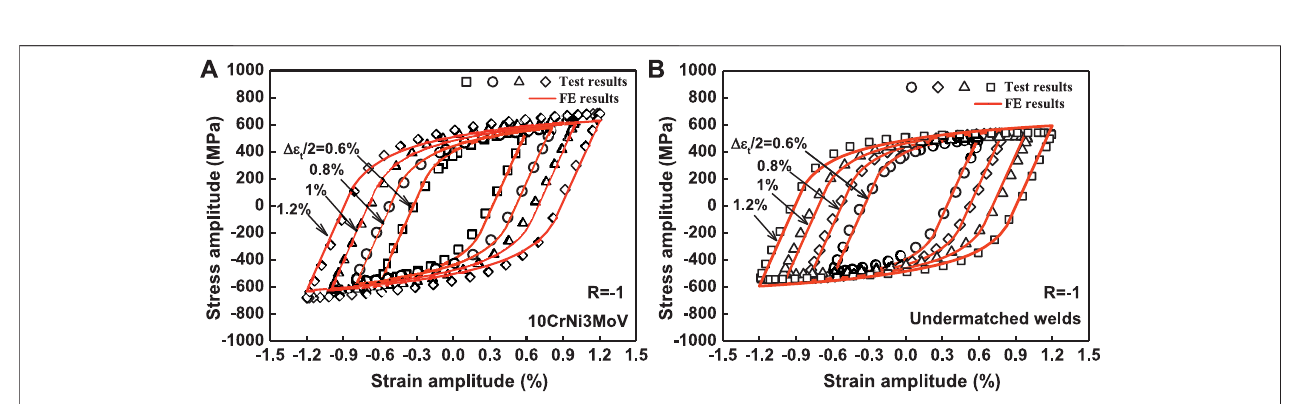
FIGURE 8 | Experimental data and simulation results of hysteresis loops at the half-life cycle for specimens. (A) 10CrNi3MoV steel and (B) undermatched welds.